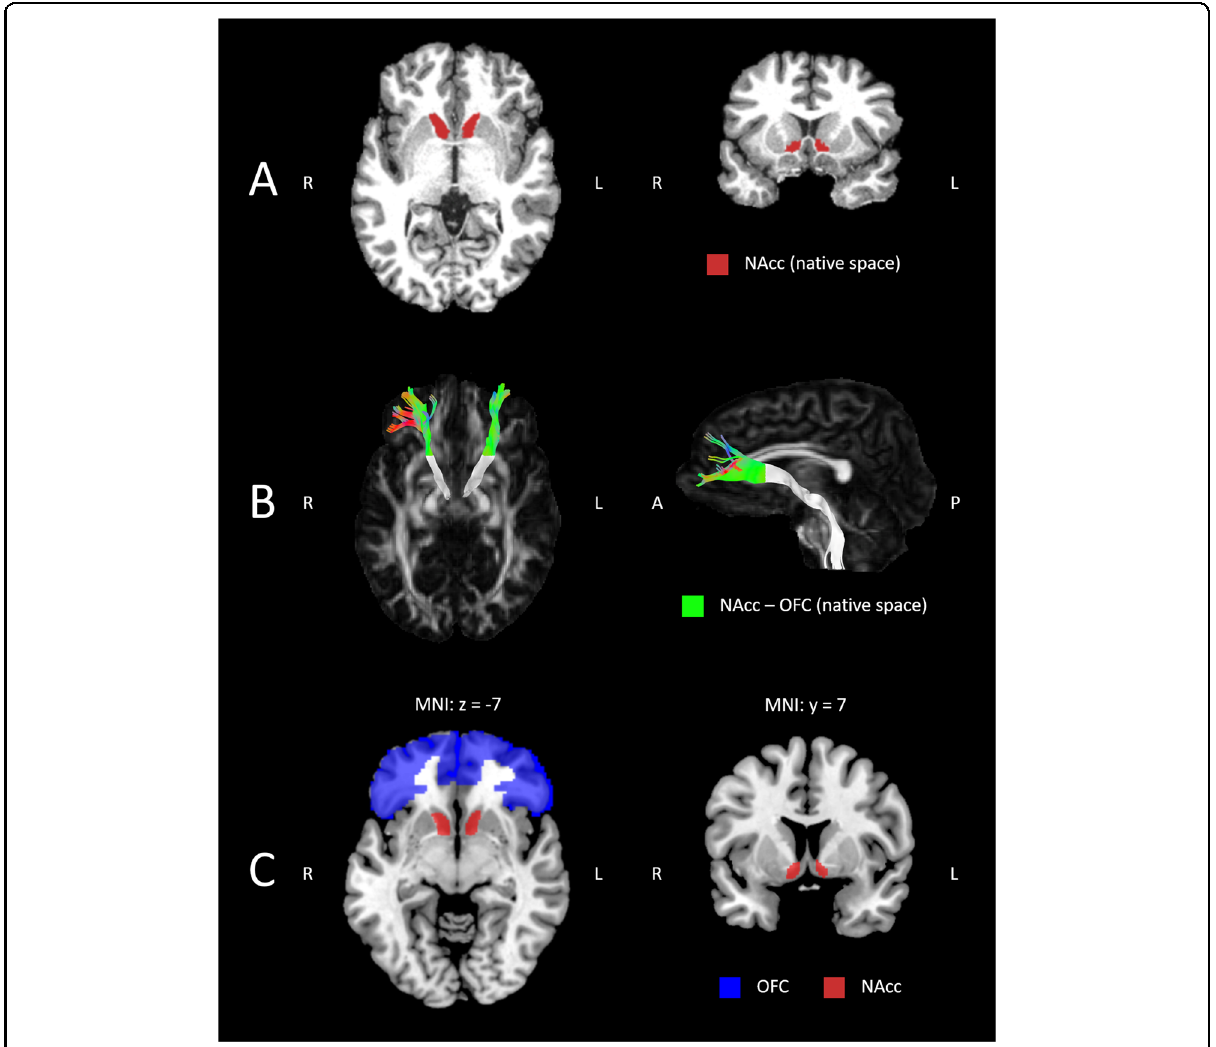
Fig. 1 Multimodal imaging analyses. A Example volumetry of bilateral NAcc in native space. B Example of individual native space OFC-NAcc connections (color coded) and the remaining proximal segment (in gray). C OFC (BA 10 and 11) and NAcc masks in MNI space for computation of bilateral OFC-NAcc